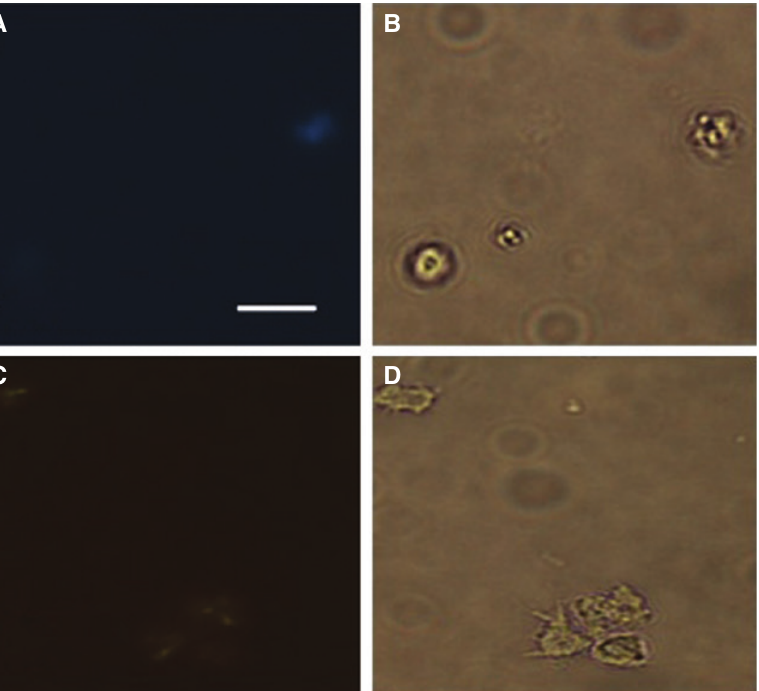
Figure 2: Auto-fluorescent vacuoles and lysosomes in cells that just emerged from spores. (A) Fluorescence microscopy images of auto-fluorescent vacuoles and (B) light field microscopy images of the same cells. (C) Fluorescence microscopy images of lysosomes stained with NBD-PZ and (D) light field microscopy images of the same cells. Scale bar = 10 μ